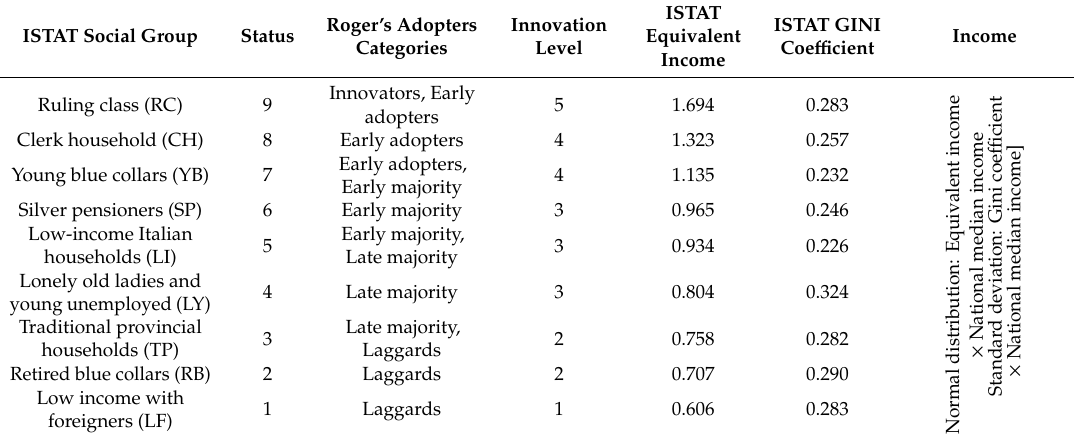
Table 4. Status, level of innovation and income with related references (adapted from Bottaccioli et al. (2019)